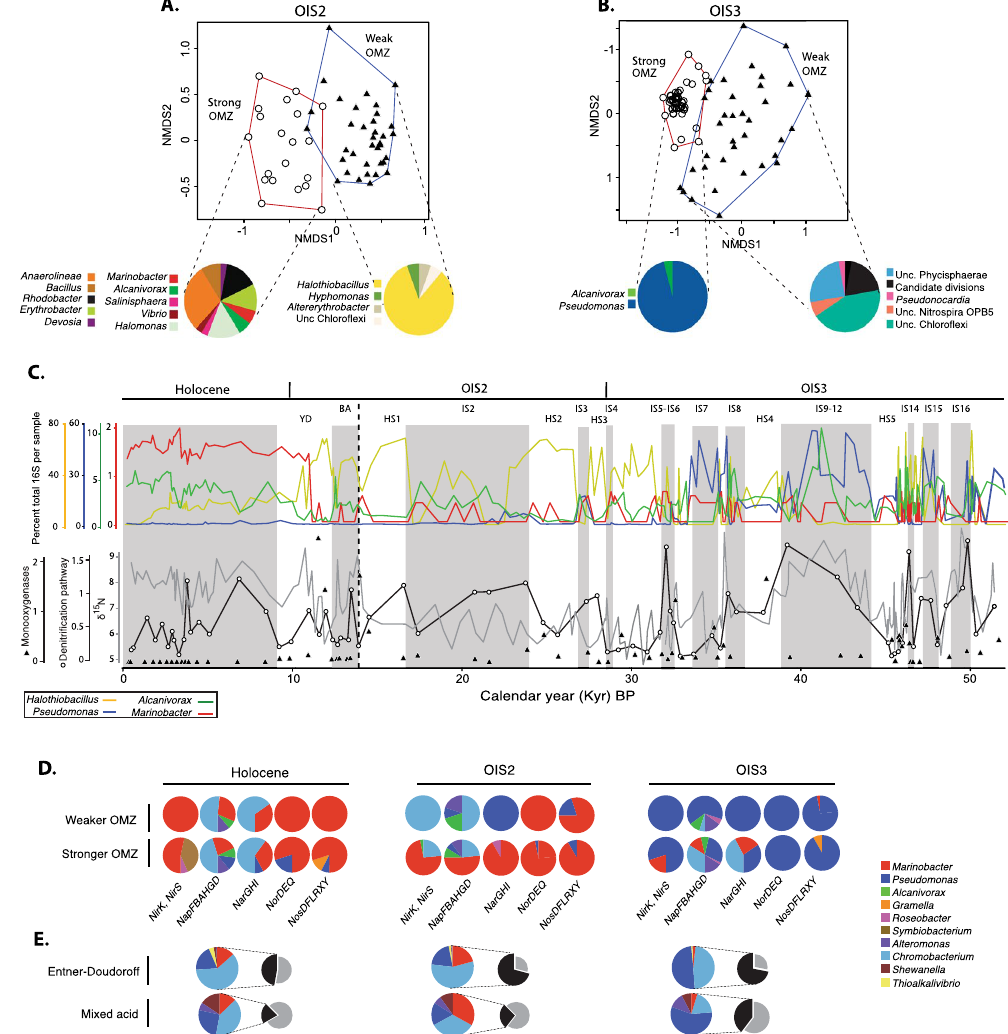
Figure 4. ( A,B ) Non-metric multidimenstional scaling analysis of bacterial 16S rRNA genes identified as indicator taxa through ISA analysis in OIS2 and OIS3. Pie charts show the distribution of significant indicator taxa for strong and weak OMZ periods, pie slices are proportional to the number of OTUs assigned as indicator taxa. NMDS stress values for OIS2 and OIS3 were 0.14 and 0,17, respectively. Note that despite being separated by depth, indicator taxa in sapropelic intervals (white circles) are significantly ( P = 0.001) different compared to those in bioturbated, organic poor intervals (black triangles). ( C ) Top panel: 16S rRNA gene stratigraphy of Halothiobacillus , Marinobacter , Alcanivorax, Pseudomonas taxa (relative abundance). Scale shows percent sequences assigned to each taxon per sample. Bottom panel: stratigraphy of the single copy gene normalized abundance of the denitrification pathway (averaged values for Nir , Nap , Nar , Nor , Nos ) in unamplified metagenomes (white dots), together with δ 15 N (grey line). Triangles display the average normalized abundance of monooxygenase gene homologs. The scales for monooxygenases and denitrification show the average abundance of the genes (either denitrification pathway, or monooxygenases) normalized against the averaged abundance of universally conserved single copy genes 49 . Shaded regions indicate sapropelic layers (strong OMZ) with increased TOC preservation, whereas un-shaded regions indicate bioturbated intervals deposited under higher bottom water oxygen concentrations (see Fig. 1A). The vertical dashed line indicates the onset of the deglacial period. ( D ) Taxonomic affiliation of denitrification genes during the three major climate stages. ( E ) Taxonomic affiliation of genes encoding the mixed acid and Entner-Dourdoroff fermentation pathways (colored pie charts). Pie charts to the right show the relative abundance of Gammaproteobacterial genera encoding the two fermentation pathways (black color), and all other bacterial genera encoding the same pathways (grey